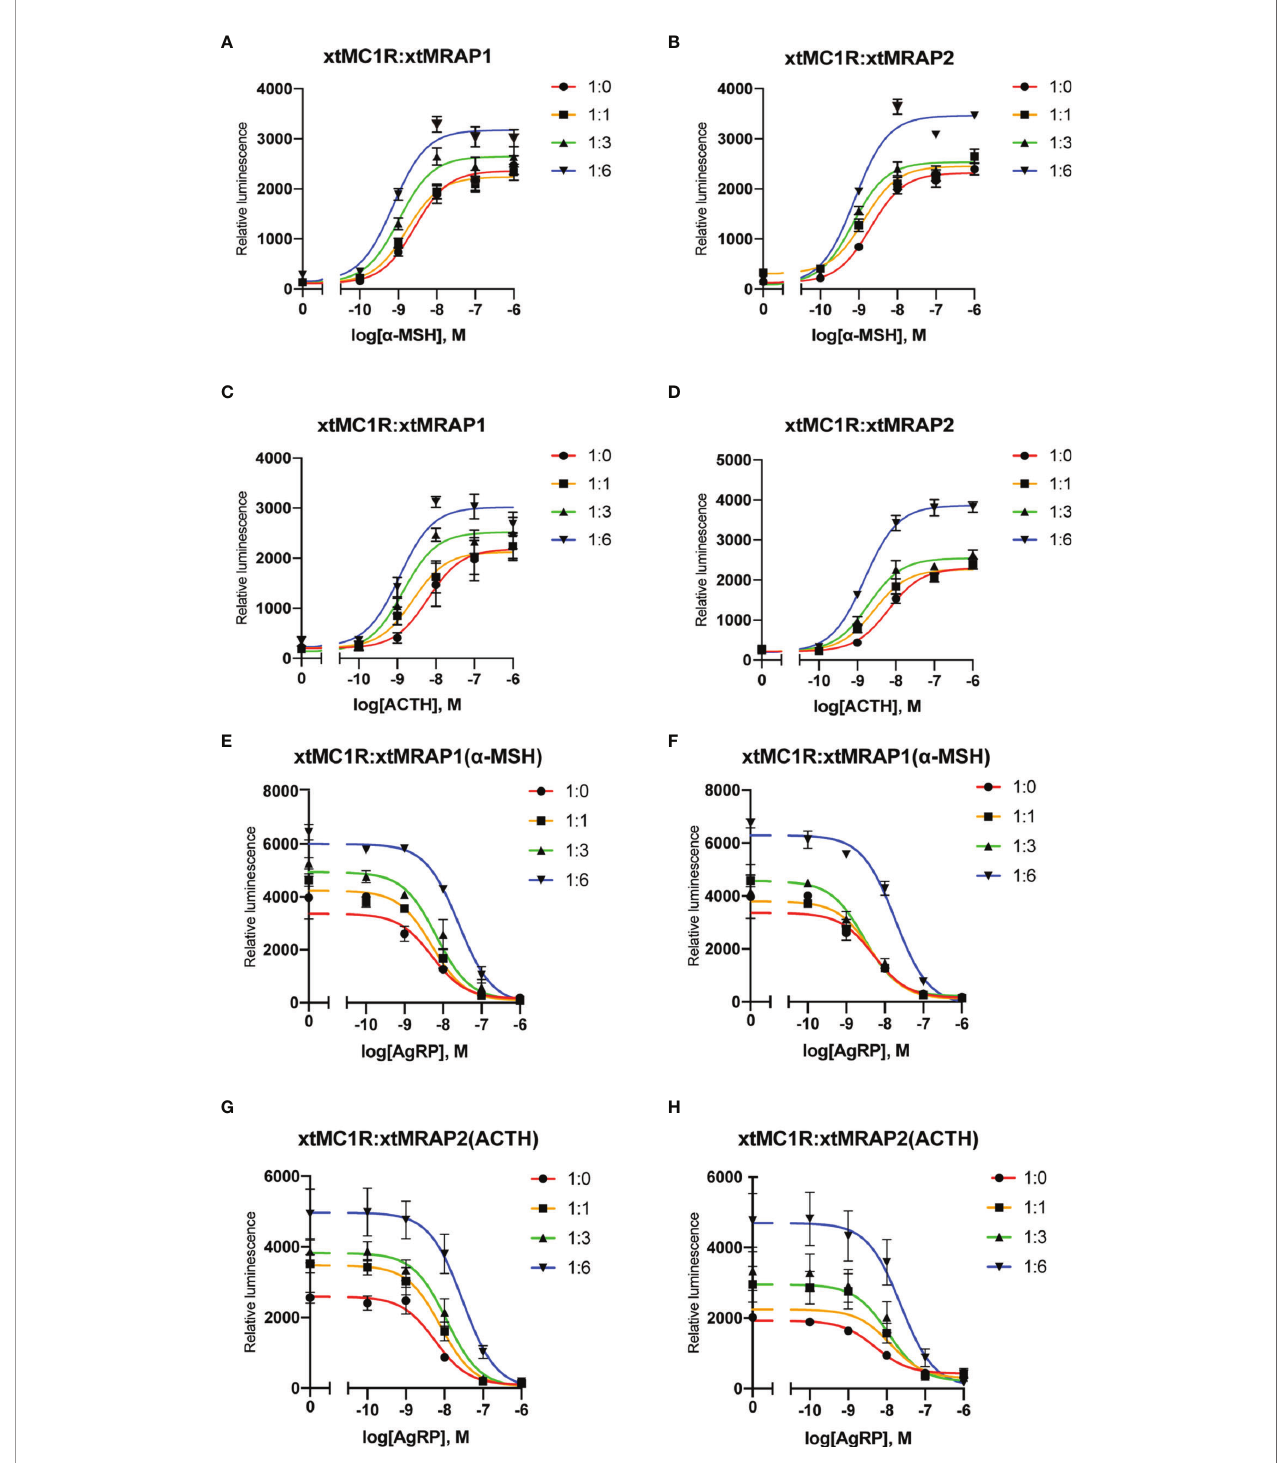
FIGURE 6 | Pharmacological modulation of xtMc1r signaling by xtMrap proteins. (A – D) Dose-responsive cAMP level of a -MSH (0 M, 10 − 11 to 10 − 6 M) and ACTH (0 M, 10 − 11 to 10 − 6 M) stimulated xtMc1r in presence of different amounts of xtMrap1 (A, C) and xtMrap2 (B, D) . Data were represented as the mean ± SEM from three independent experiments (E – H) . The antagonistic effect of AgRP (10 − 11 to 10 − 6 M) to the EC 80 dosage of a -MSH (E, F) or ACTH (G, H) induced xtMc1r signaling in presence of different amounts of xtMrap1 (E, G) or xtMrap2 (F, H) . Data were represented as the mean ± SEM from three independent